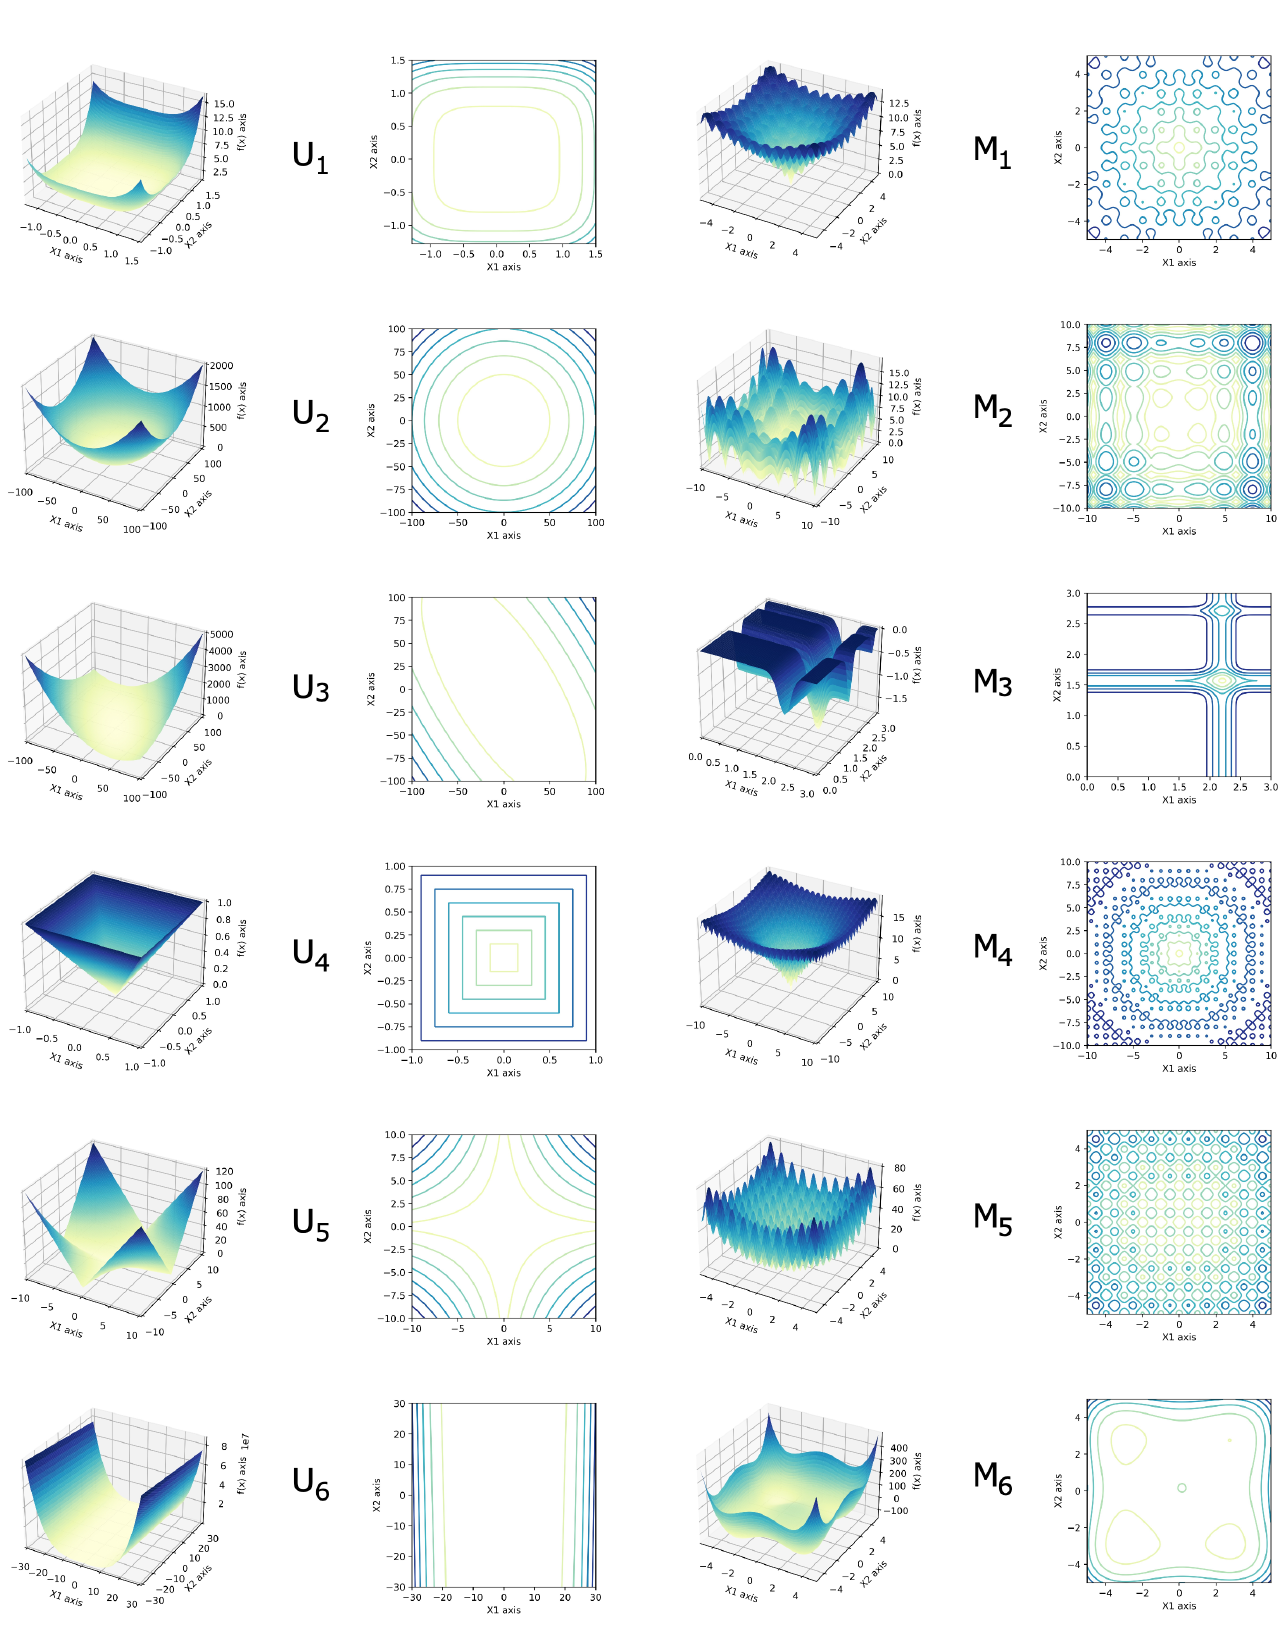
Figure 13. Three-dimensional plot of two dimension function